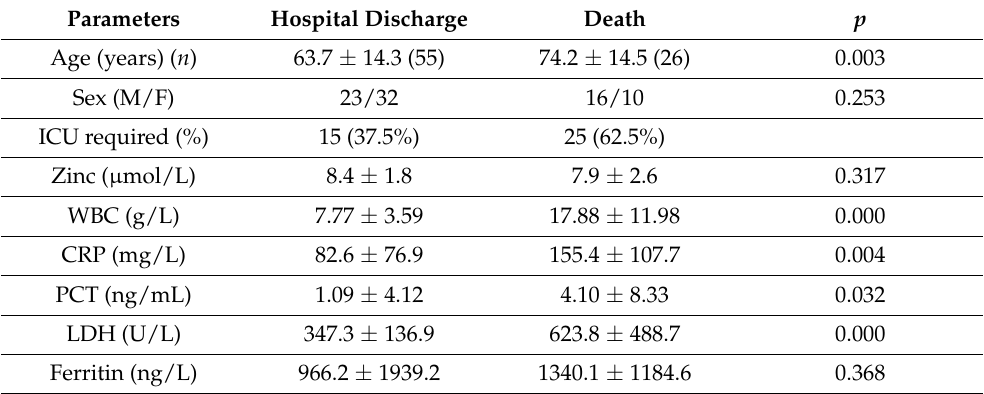
Table 3. Demographic and laboratory parameters of hospitalized COVID-19 patients according to the survival status.